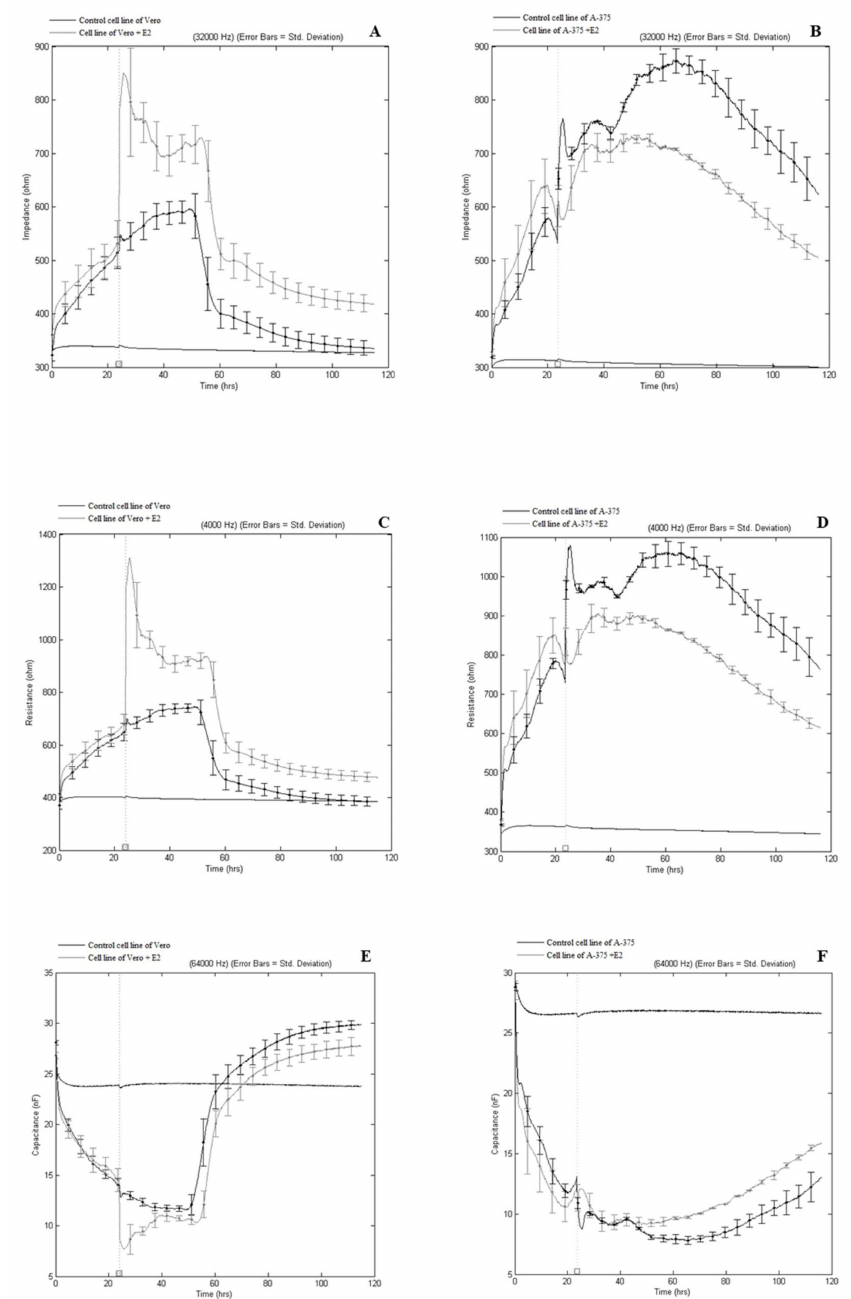
Figure 5. Changes in impedance ( A , B ), resistance ( C , D ), and capacitance ( E , F ) of Vero ( A , C , E ) and A-375 ( B , D , F ) cells treated with extract